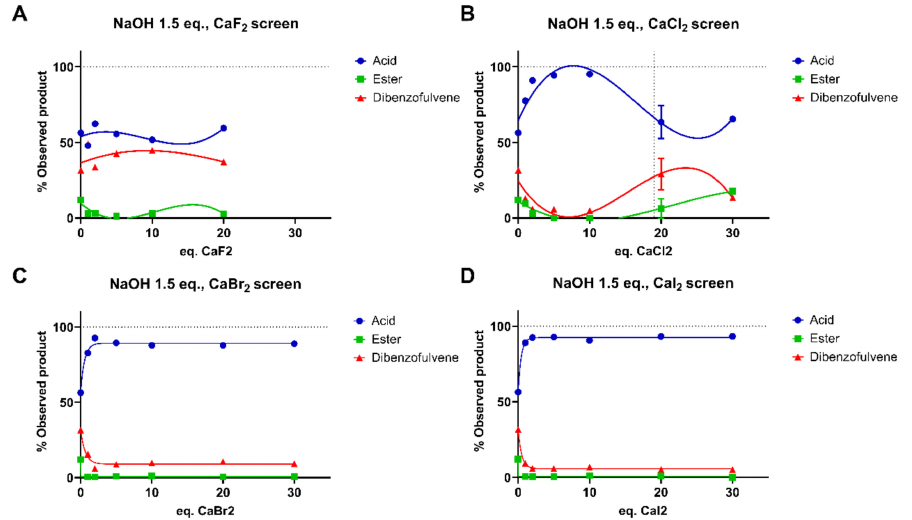
Figure 4. Screening of the nature and number of equivalents of the inorganic salt using 1.5 eq. of NaOH in an acetone/water ratio of 2.3:1 at RT for 4 h: ( A ) 0 to 20 eq. of CaF 2 ; ( B ) 0 to 30 eq. of CaCl 2 ; ( C ) 0 to 30 eq. of CaBr 2 ; ( D ) 0 to 30 eq. of CaI 2